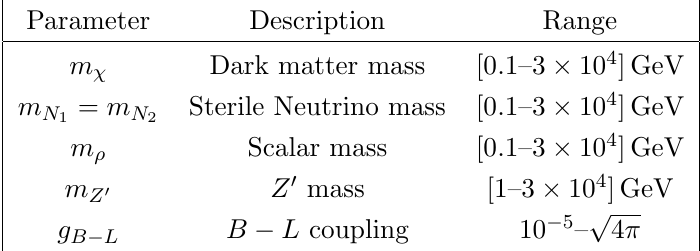
p 8 (cid:25) and g p 4 (cid:25) B (cid:0) L (cid:20) (cid:20)